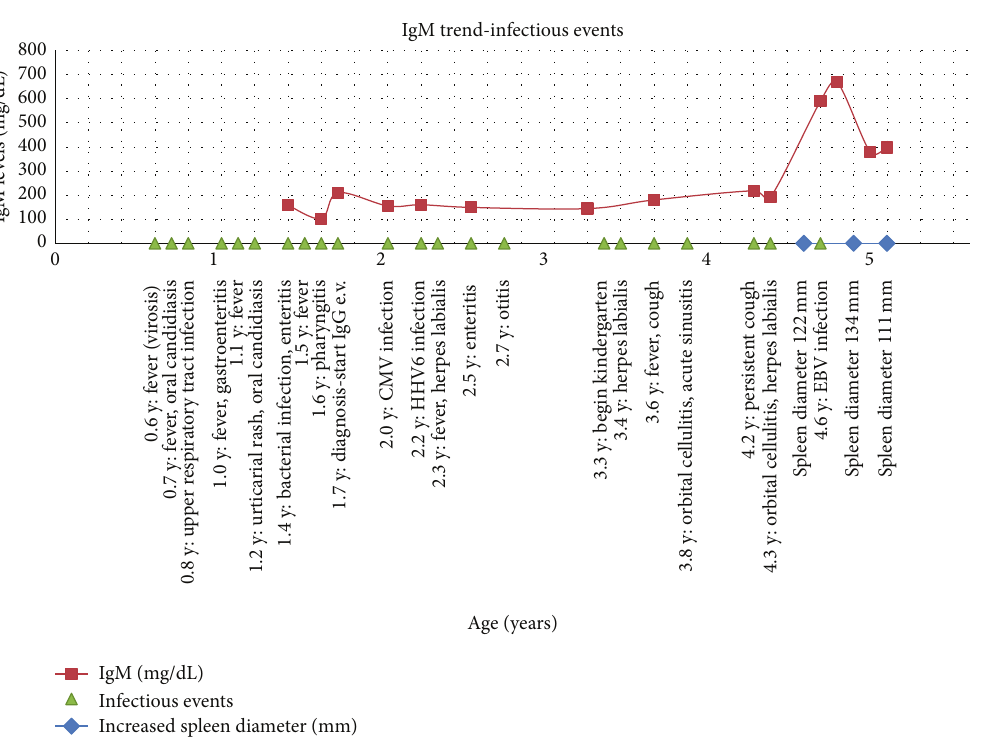
Figure 4: IgM levels according to history infections. Note the increasing levels of IgM simultaneously to EBV-DNA copies and spleen